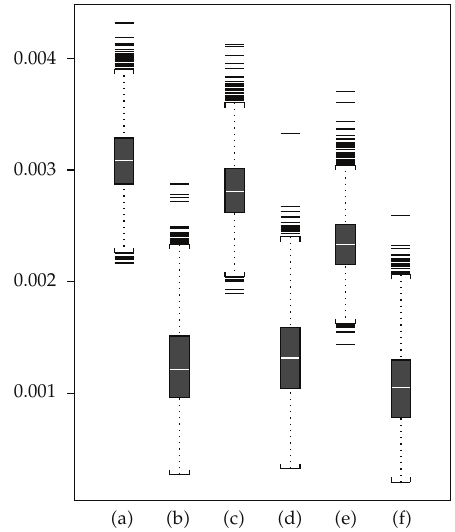
Figure 3: Example 5.1: Boxplots of the 5000 RMSE-values using estimators with the Daubechies D12 wavelet, for linear estimates (cid:5) a (cid:6)